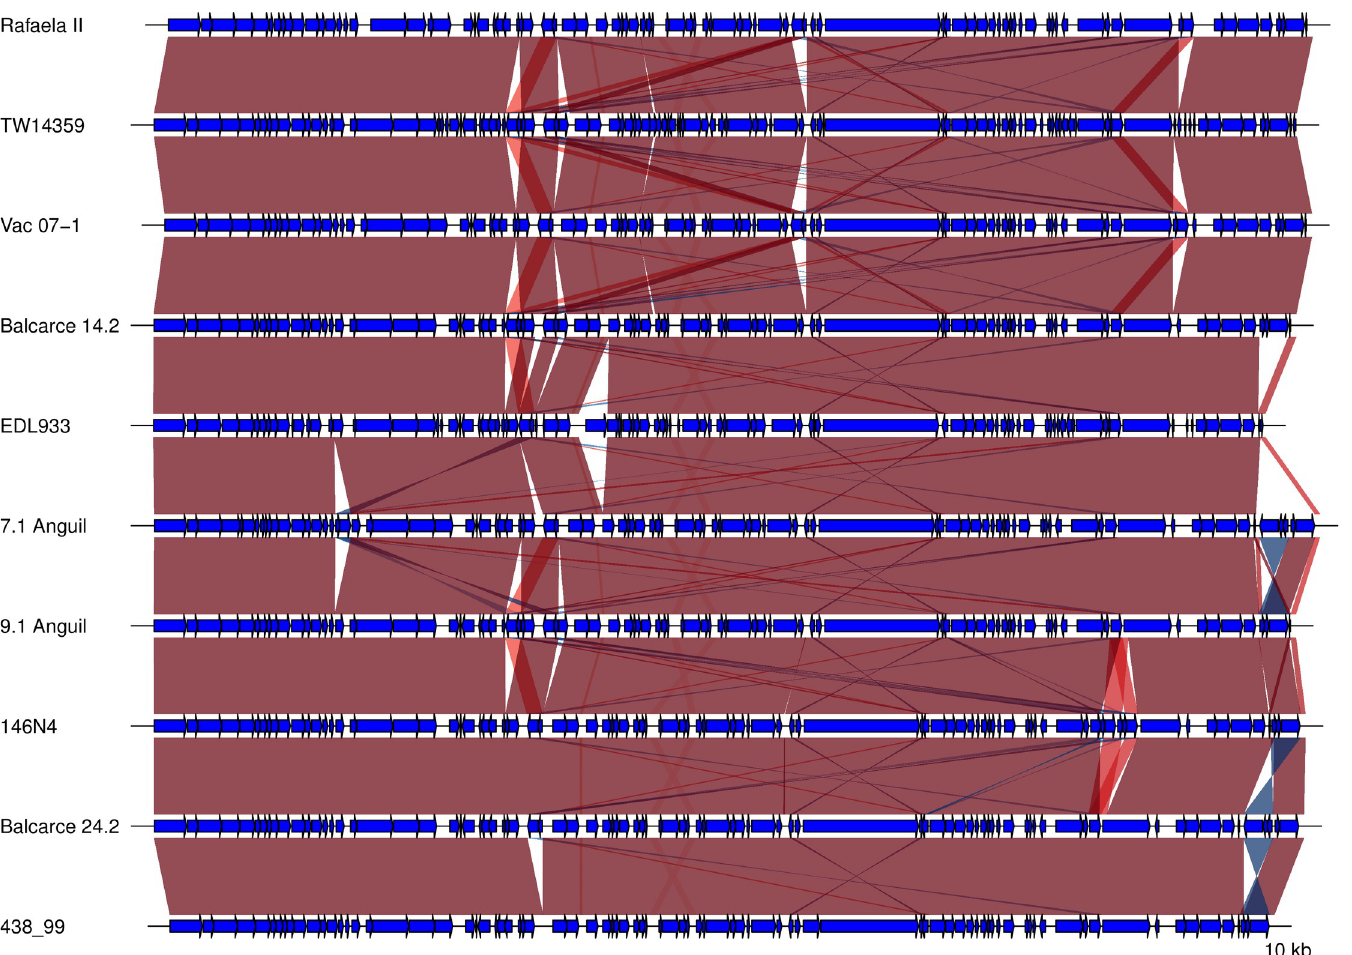
Fig 3. Alignment of pO157 plasmids from EHEC O157 isolates. Plasmid are represented in lineal forms with the ORF colored blue. The tagA gene was oriented at the 5 ´end to allow for comparison of plasmid architecture. Artemis comparison tool was used to indicate regions of similarity (red), inversions (blue) and In/dels